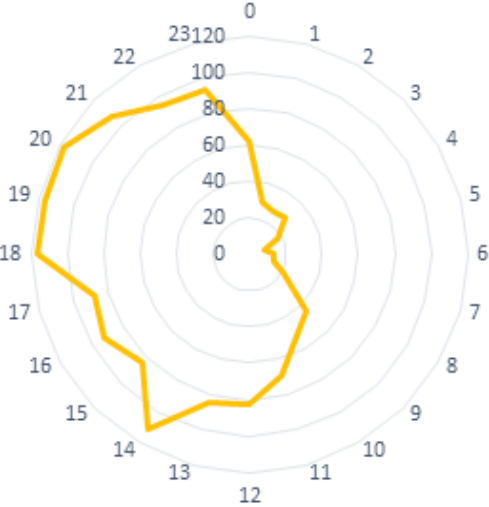
Figure1. Radar chart of the number of TAs in 24-hour